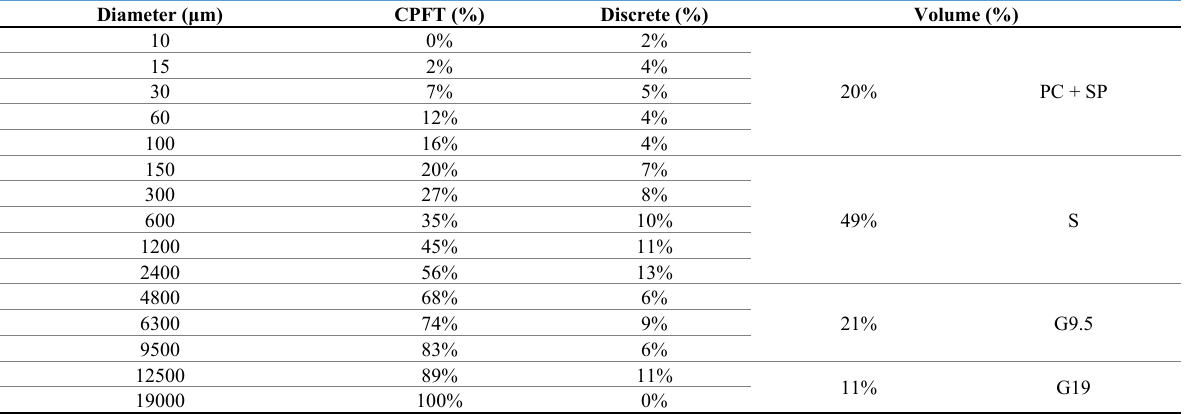
Table 4. Application of the Alfred model with q = 0.21.